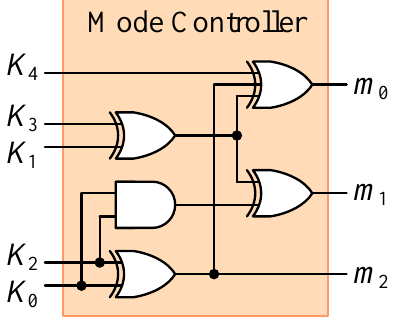
Figure 6. The circuit of the mode controller.